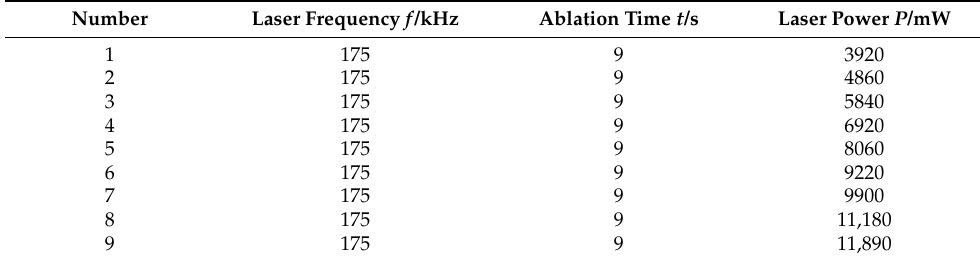
Table 2. The femtosecond laser ablation experimental parameters of SiC